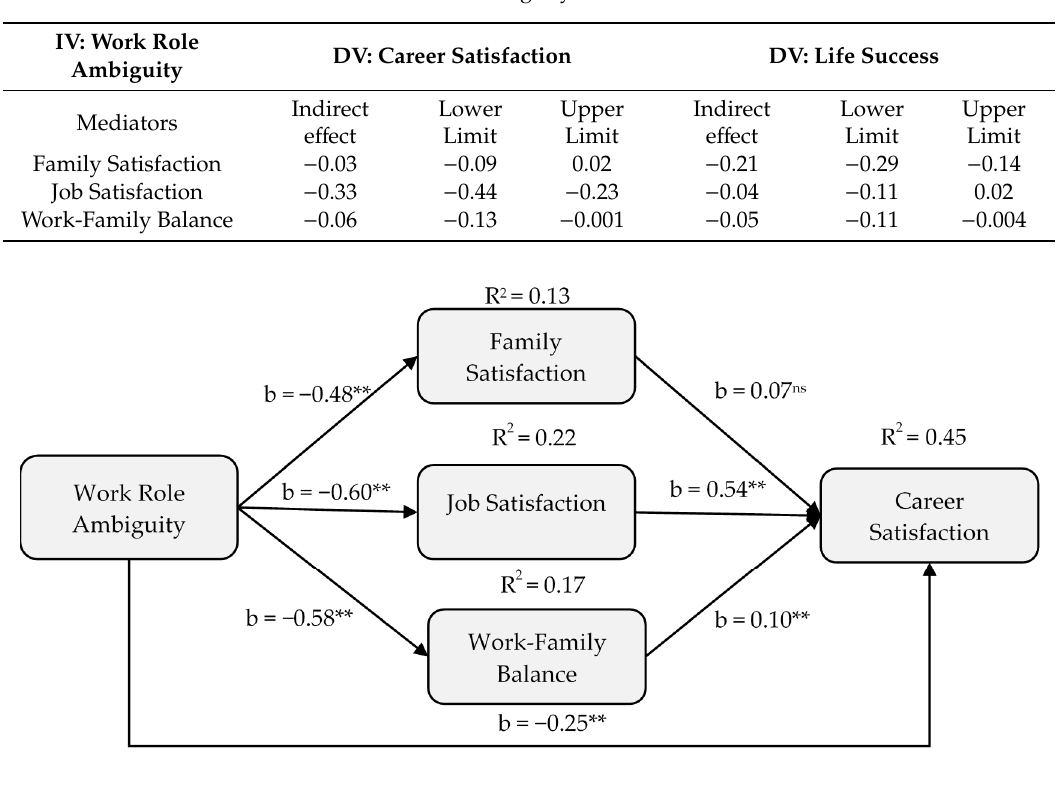
Table 4. Indirect e ff ects of work role ambiguity on career satisfaction and life success.